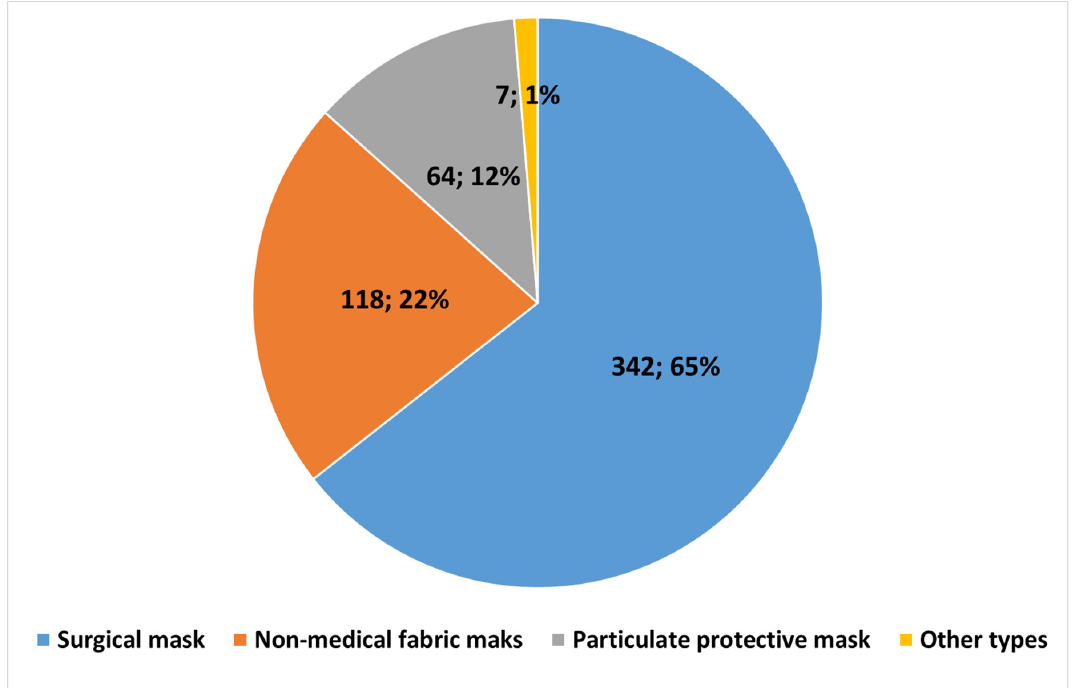
Figure 2. Different types of face masks used by the students of Mongar Higher Secondary School, Bhutan. Note: Actual numbers and percentages.